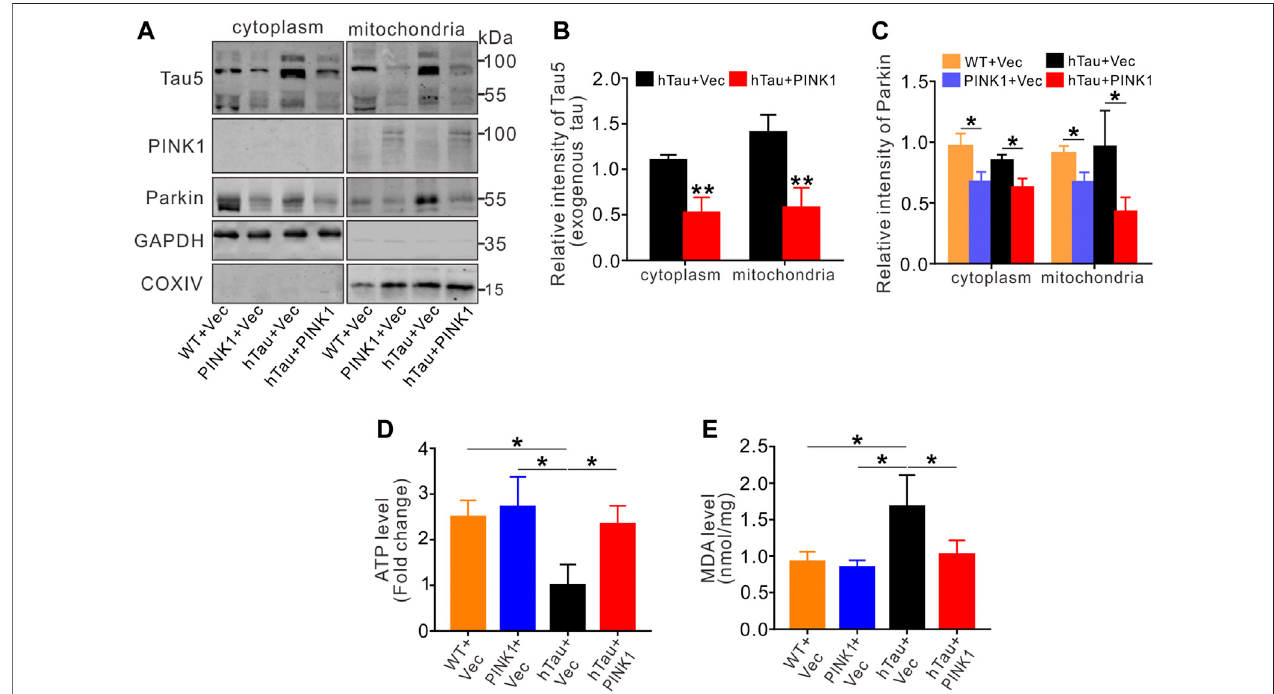
FIGURE 7 | PINK1 reduces tau accumulation in mitochondria and rescues mitochondrial disorders. (A – C) The levels of exogenous tau ( ∼ 106 kDa, human tau) (A,B) or Parkin (A, C) in both cytoplasm and mitochondria fraction of mice hippocampal CA1 region were detected by Western blot and quantitative analysis. Unpaired t-tests. * p < 0.05, ** p < 0.01. (D, E) Overexpression of PINK1 reversed the decreased ATP levels (D) or increased MDA levels (E) in hTau mice. One-way ANOVA followed by Tukey multiple-comparisons tests. * p < 0.05. All data were presented as mean ± SD. n (cid:2) 3 mice for each